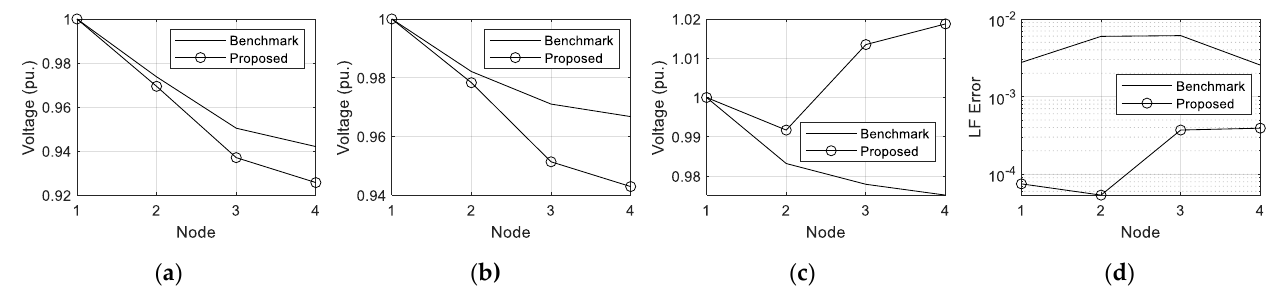
Figure 9. Comparison between benchmark and proposed methods at ( a ) Phase − AN, ( b ) Phase − BN, ( c ) Phase − CN, and ( d ) errors in LF results.